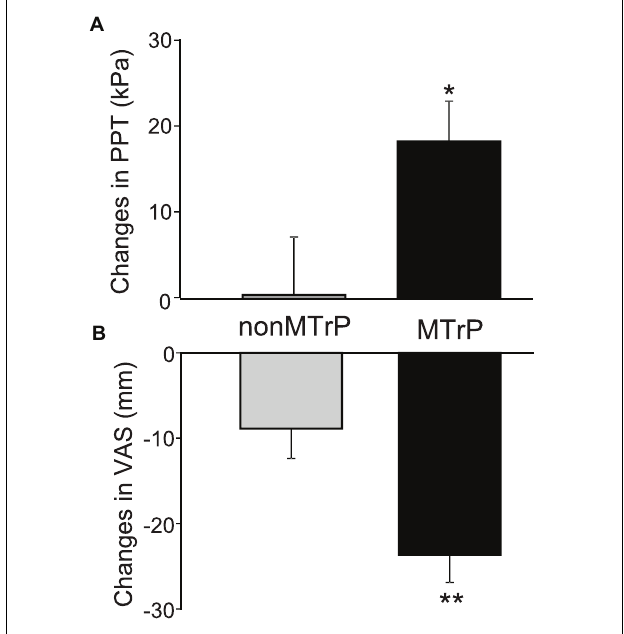
FIGURE 3 | Changes of PPT (A) and VAS scores of low back pain (B) before and after compression in the MTrP and non-MTrP groups. Note that compression significantly increased PPT (A) and decreased VAS pain (B) in the MTrP group compared with the non-MTrP group ( P <